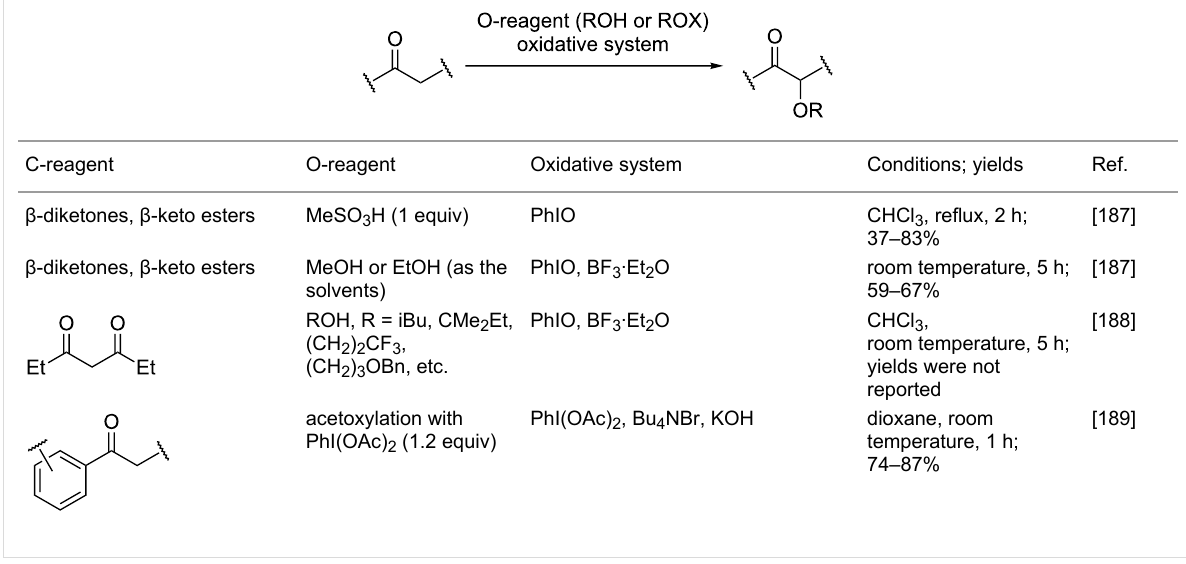
C-reagent O-reagent Oxidative system Conditions; yields